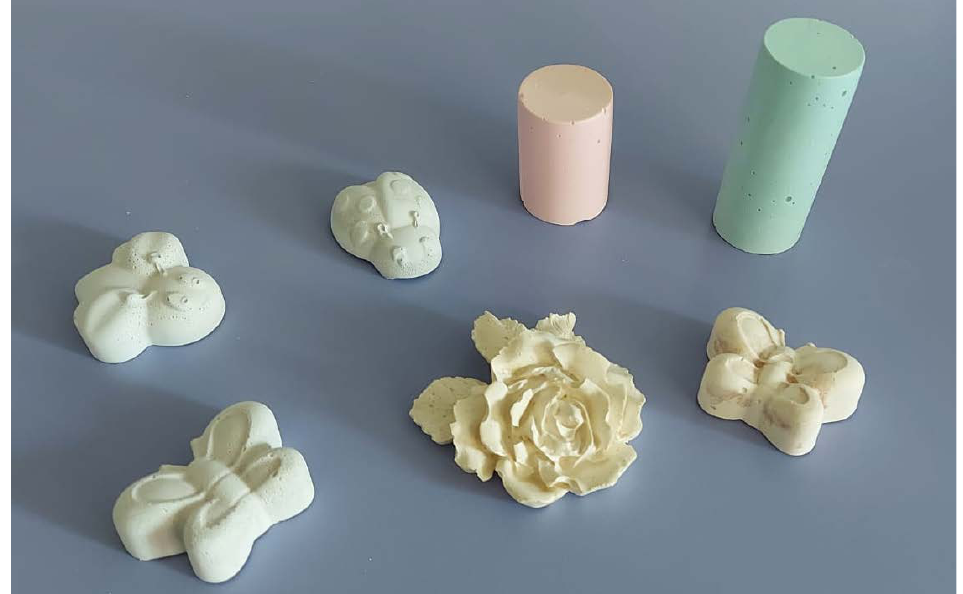
Figure 7. Examples of coloured artefacts created with the geopolymer-based materials described in this paper. As apparent, even objects with complex shapes can be easily realized by a simple casting procedure.